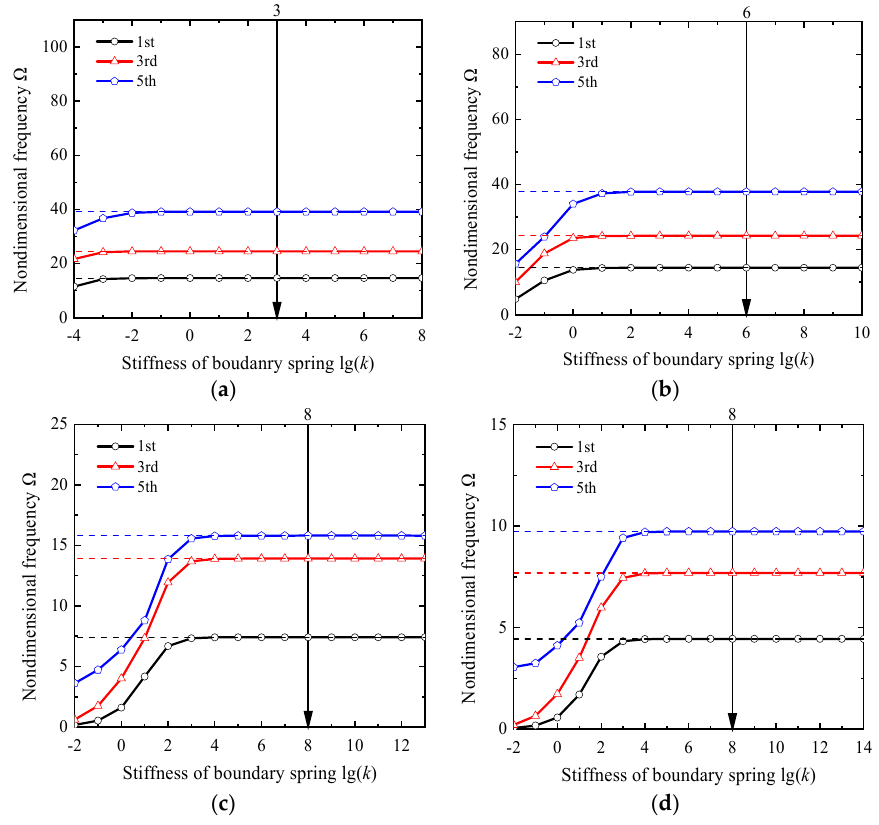
Figure 7. Variations of nondimensional frequencies Ω for CCCC laminates (0°, 90°, 0°) versus the stiffness of boundary spring ( k t = k r 1 = k r 2 = k ): ( a ) h/b = 0.001; ( b ) h/b = 0.01; ( c ) h/b = 0.1; ( d ) h/b = 0.2.